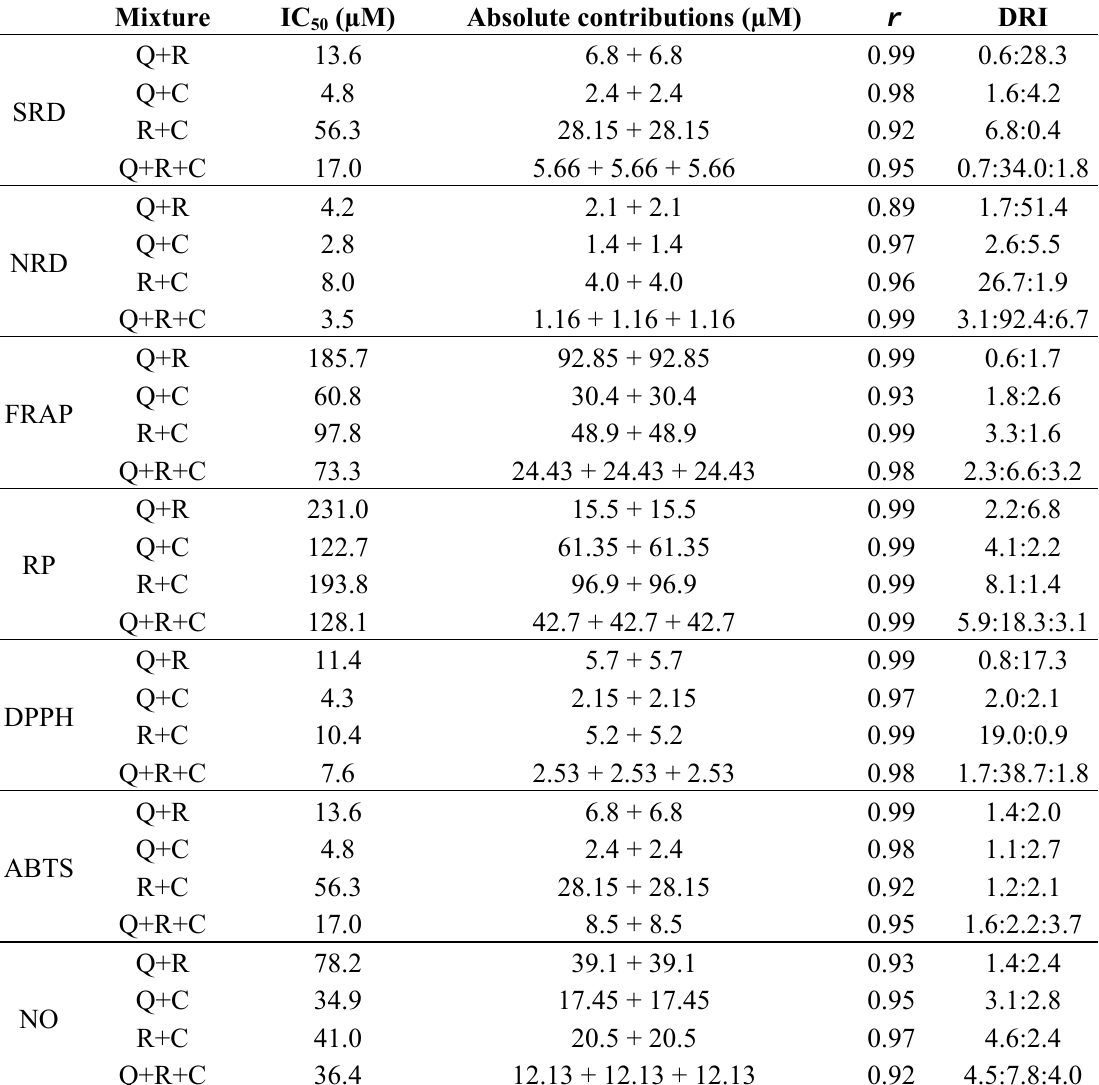
Table 2. Median inhibitory activities (IC ), the absolute contributing concentrations of the 50 single compounds (µM), correlation coefficients r and dose-reduction index (DRI) of equimolar mixtures of polyphenols in different antioxidant